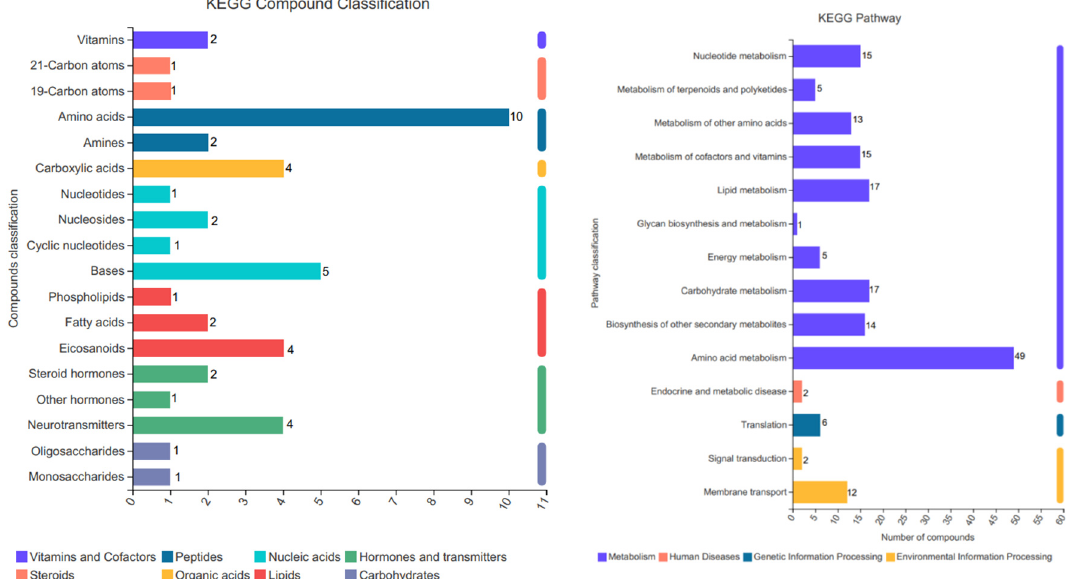
Figure 6. KEGG classifications and functional pathways. During the harvest period (August 24), metabolomics analyses were conducted. K concentrations: K 0 (0 mg ∙ L − 1 ), K 2 (671.4 mg ∙ L − 1 ). The ordinate is the KEGG compound classification, and the abscissa is the number of compounds annotated to the class; the color representation of the bar belongs to the compound primary category.